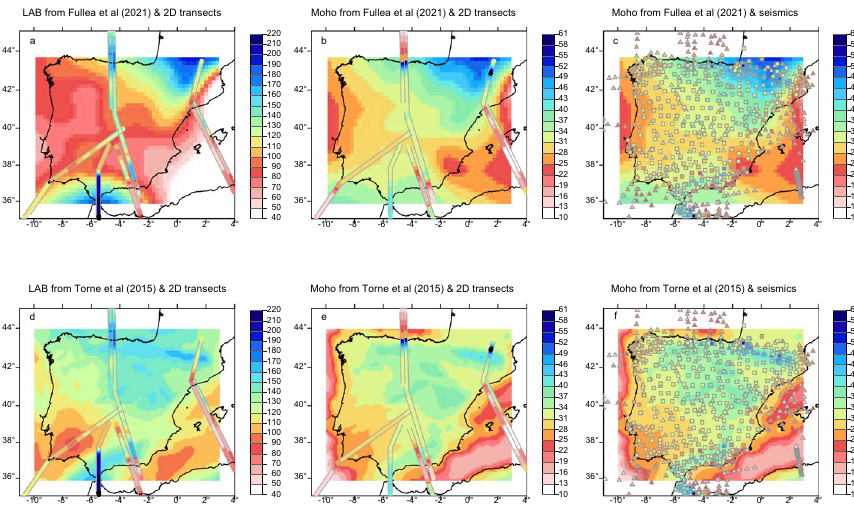
Fig. 4 Results of the 2D lithospheric–thermal models superimposed on the thermal model of Fullea et al. (2021) (top a – c ) and of Torne et al. (2015) (bottom d – f ). a , d Base of the thermal lithosphere, b , e Moho depth and c , f comparison of the Moho obtained by thermal modeling and that observed from seismic Deep Seismic Sounding (triangles) and Receiver Functions (squares). Seismic results from Díaz et al. (2016). Thick colored lines show results from 2D thermal models referenced in Fig. 3 caption and along the